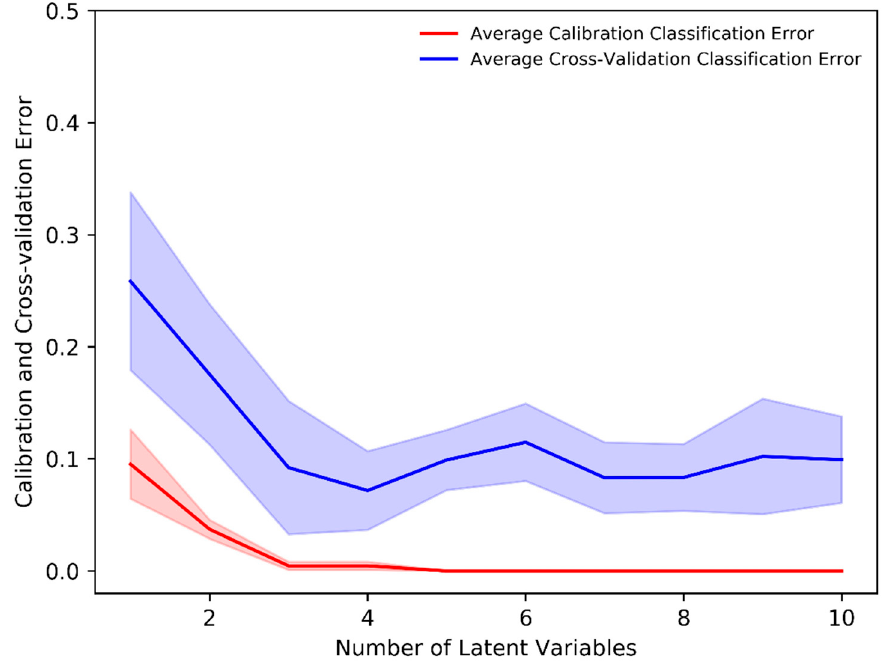
Figure 3. Average calibration and cross-validation classification error evaluated through the stratified K-fold (K = 10) cross-validation in the PLS-DA classification model.